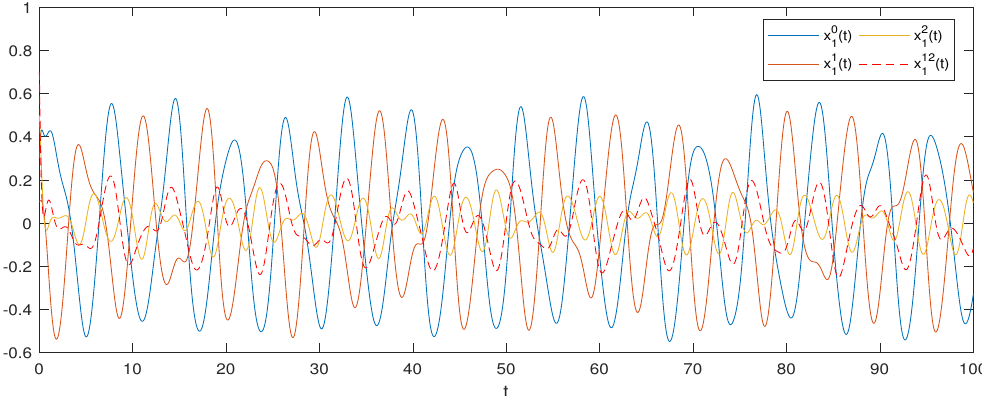
Figure 1. The states x 0